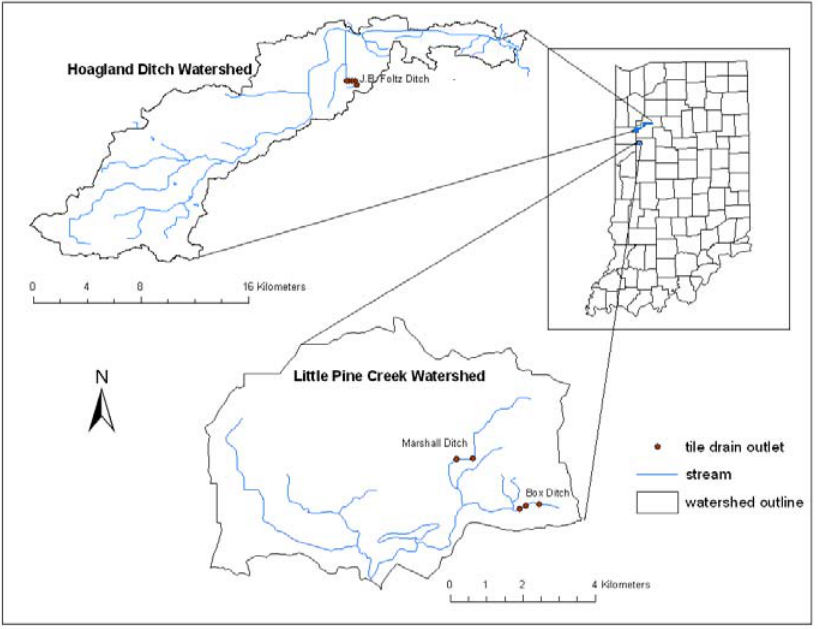
Figure 1. Locations of study sites in Hoagland Ditch and Little Pine Creek